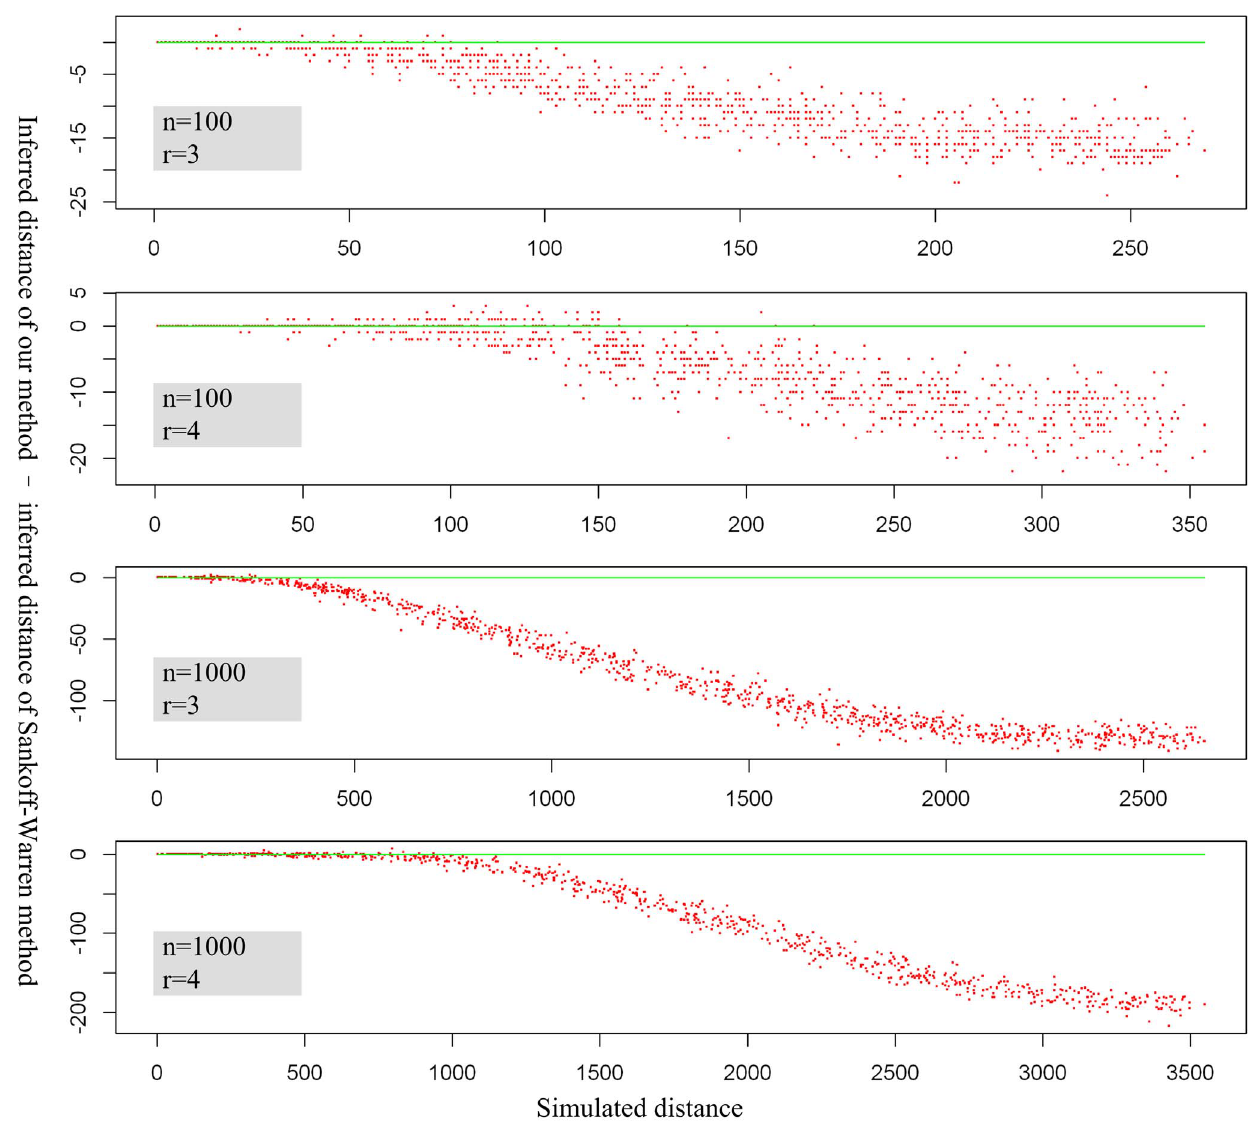
Figure 6. Comparison of inferred distance computed using Sankoff-Warren’s algorithm and our own algorithm. Each red point is a simulation data point. The proportions of data points calculated using our method with inferred distances larger than those calculated using the Sankoff-Warren method are 0.7%, 5.9%, 0.5% and 3.2% (from the upper to bottom panels, respectively). Green line: y=0. The variable n is the number of gene families, and r is the duplicated size of G obs .